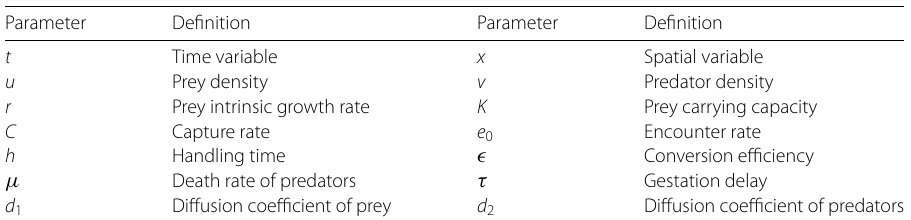
Table 1 Biological description of